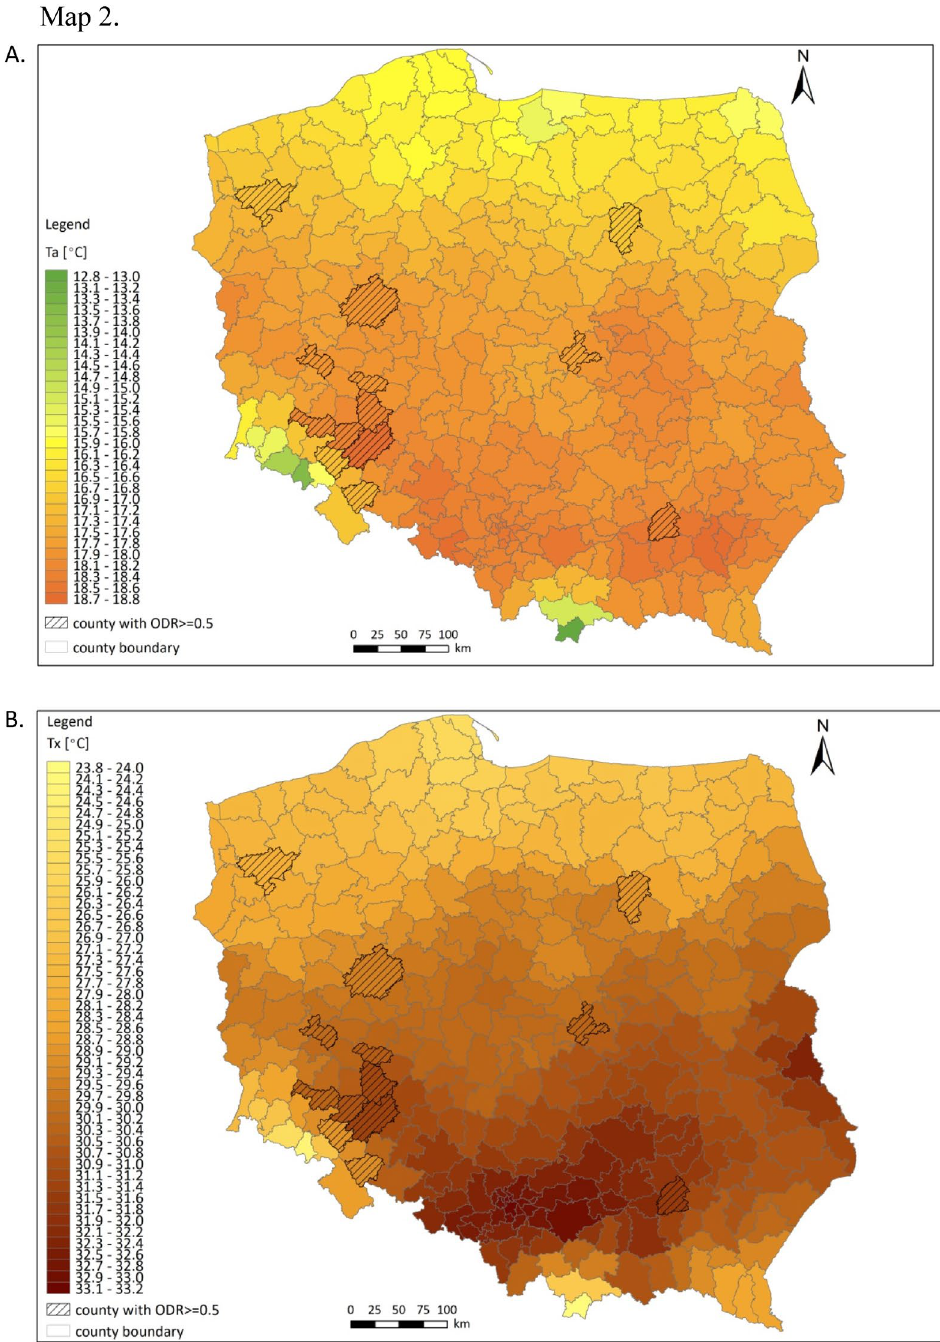
Figure 10. Regional mean monthly air temperatures (Ta, A ) and mean monthly temperatures of daily maxima (Tx, B ), and locations of districts in Poland with ODR values ≥ 0.5 (hatching); example for June